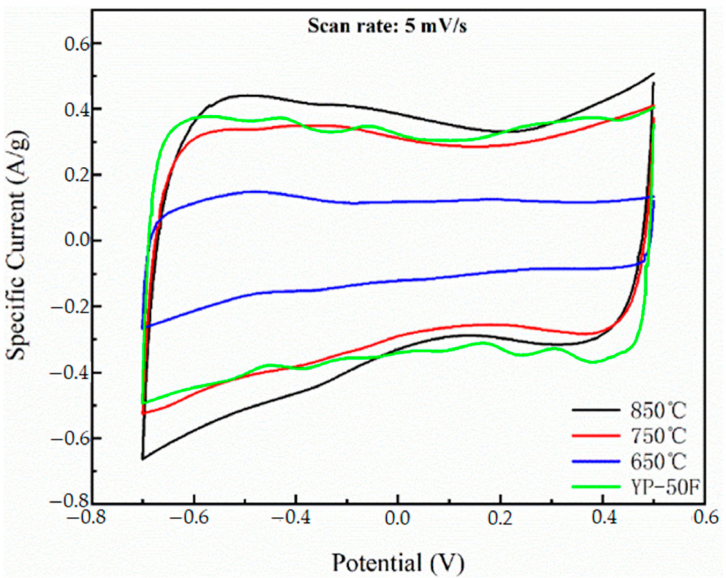
Figure 11. CV curves of 650, 750, 850, and YP-50F at a scanning rate of 5 mV/s.